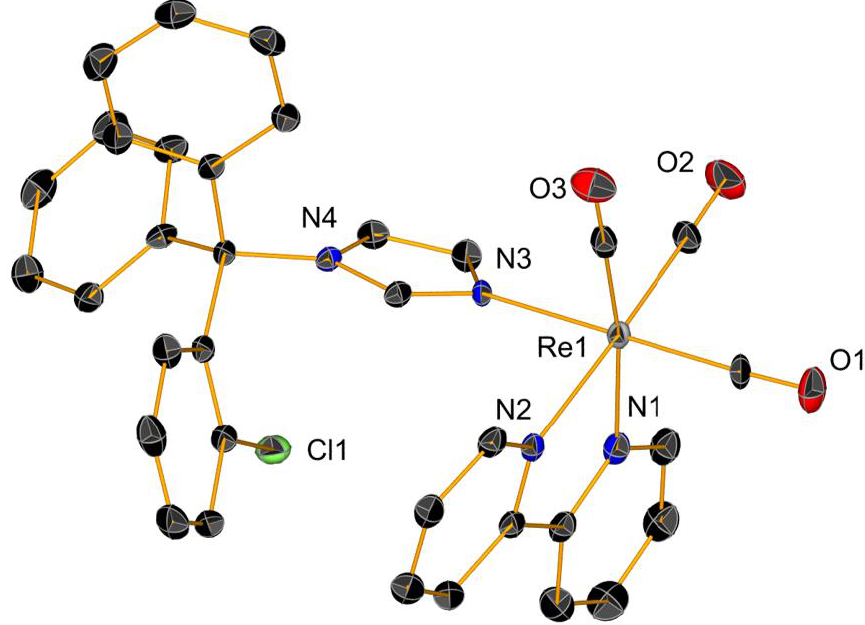
Figure 4. Crystal structures of complex 1 . Thermal ellipsoids are at 30% probability. Hydrogen atoms are omitted for clarity.